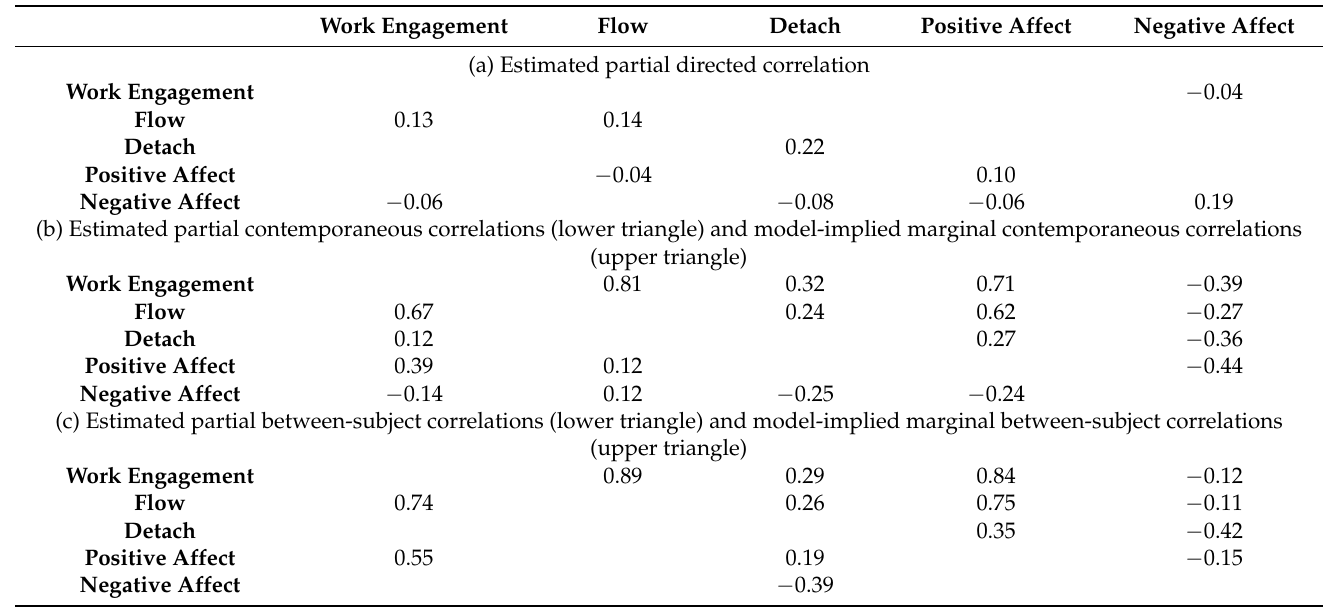
Table A1. Numeric results of the temporal network analysis of the daily variables by panel-vlgvar package.